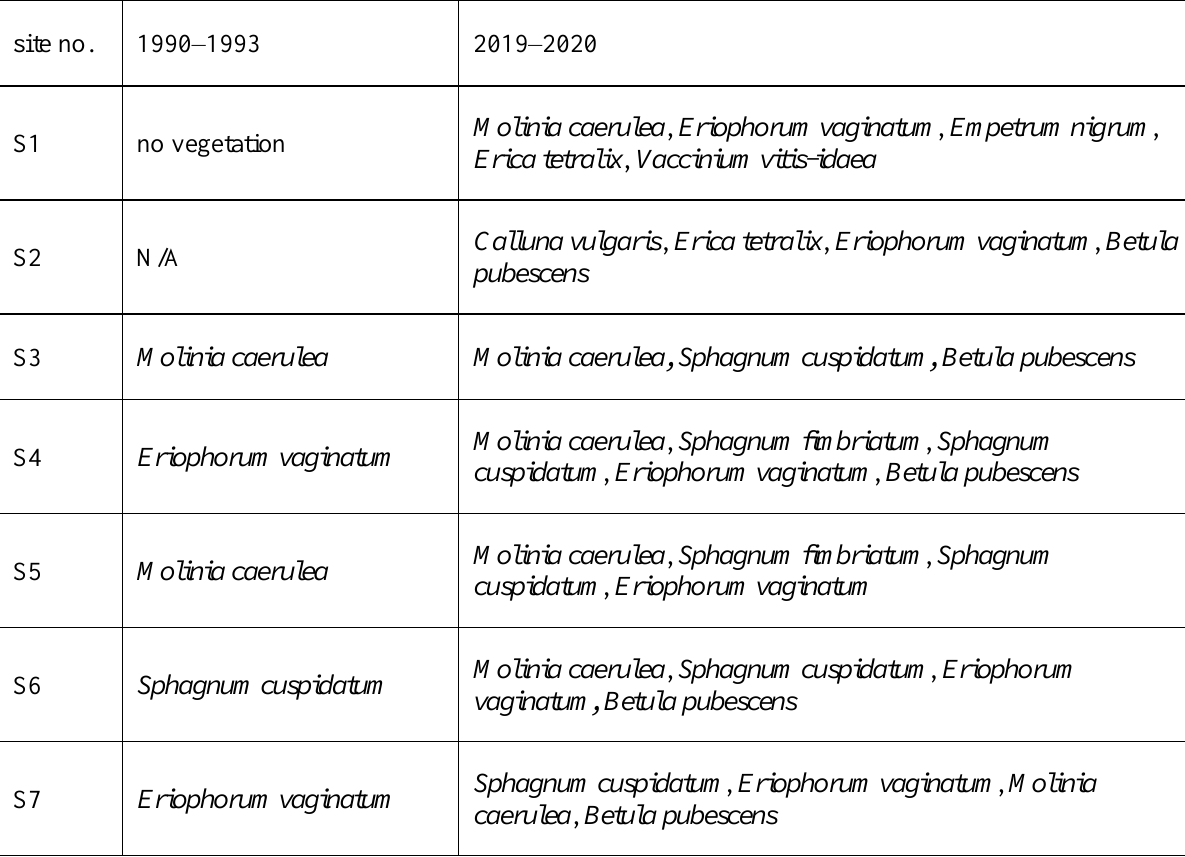
Table A2. Plant species recorded at the soil sampling sites on the Leegmoor during the initial examination in 1990–1993 (Gebhardt & Knabke 1994) and the follow-up examination in 2019–2020. For each sampling location, species are listed in descending order of abundance. N/A = data not available. site